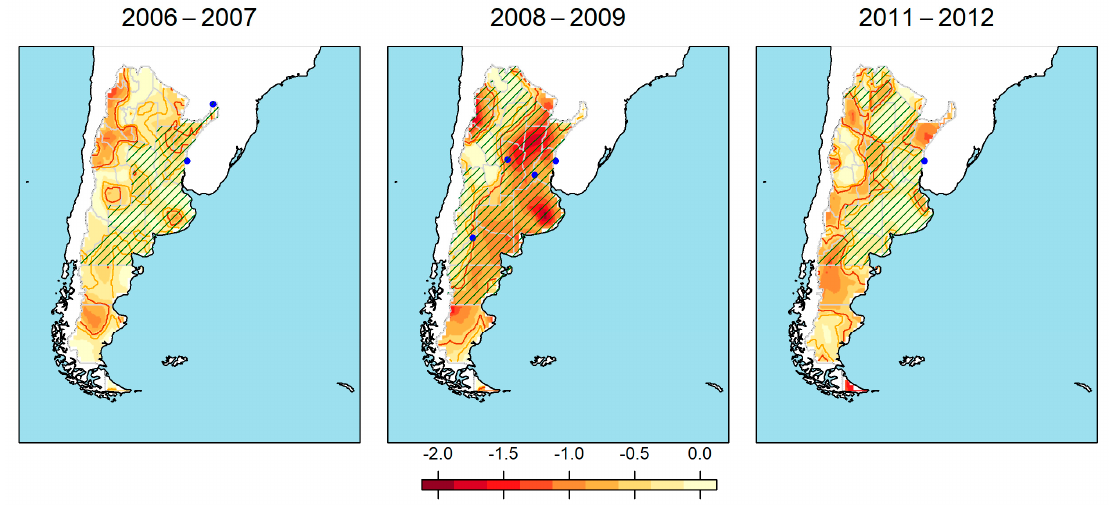
Figure 3. Intensity of drought conditions according to SPEI-12 in Argentina during the events 2006– 2007, 2008–2009, and 2011–2012. Orange (red) contours represents the level of severity where at least half year (one year) was affected by a magnitude of SPEI ≤ − 1. Hatched lines represent districts were impacts on agriculture and livestock production were reported or emergencies were triggered, while the blue points represent registered hydrological impacts.